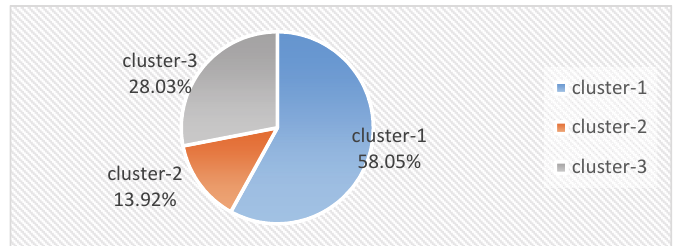
Fig. 6. Percentage of product clusters for scenario 8 in situation 1